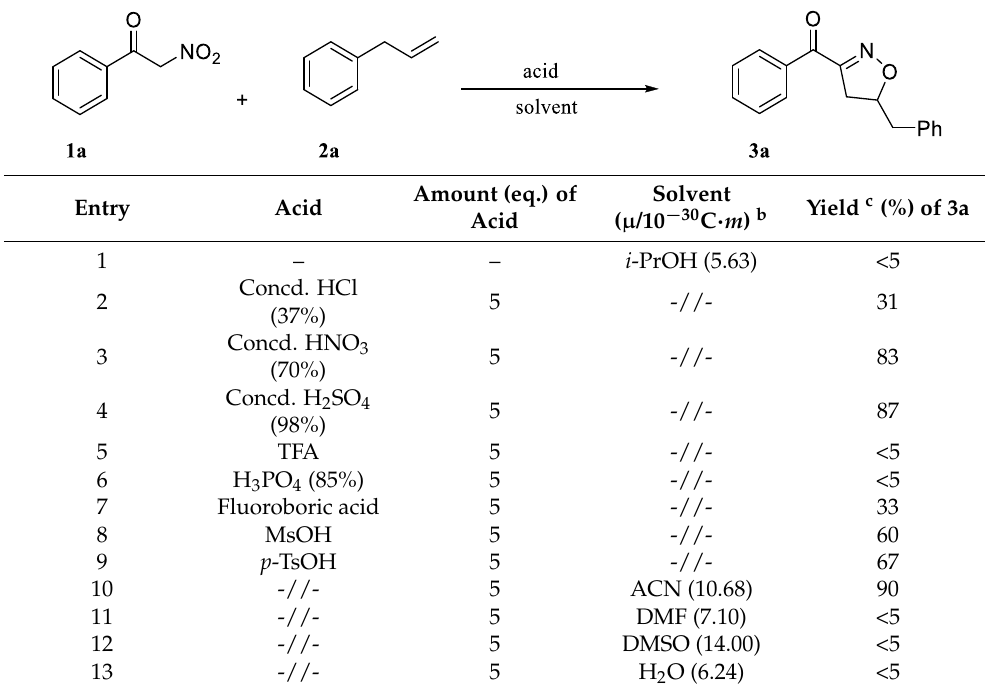
Table 1. Reaction condition optimization a .